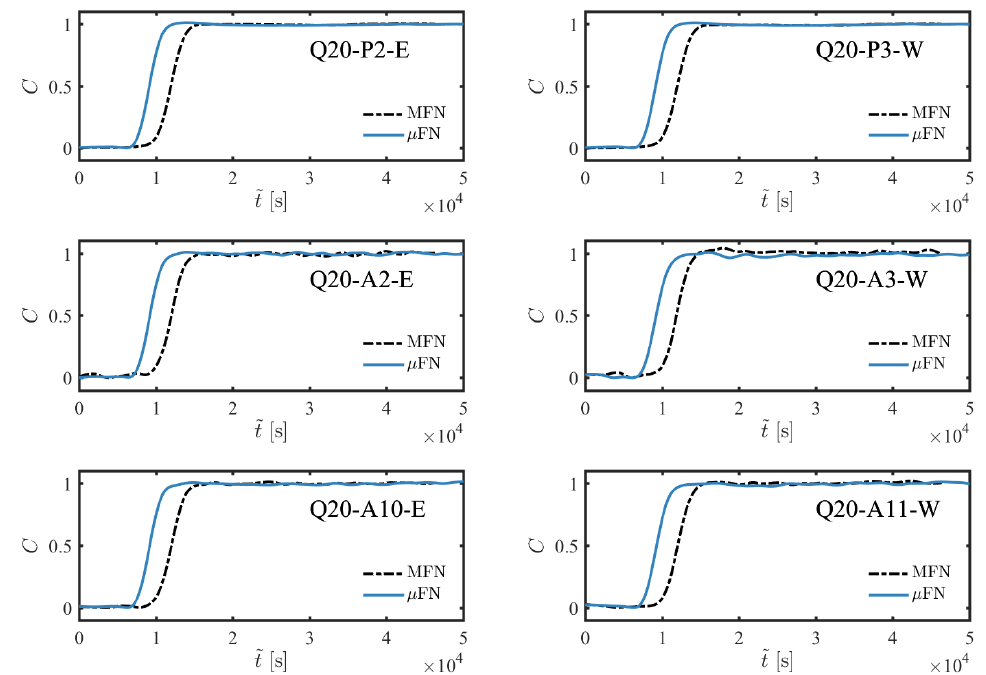
Figure A10. Breakthrough curves measured in physical time in the MFN (dashed line) and µ FN (solid line) at upstream (east) and downstream (west) locations on the same primary (P2–P3), secondary (A10–A11) and tertiary (A2–A3) fracture at Q = 20 µ L/h.